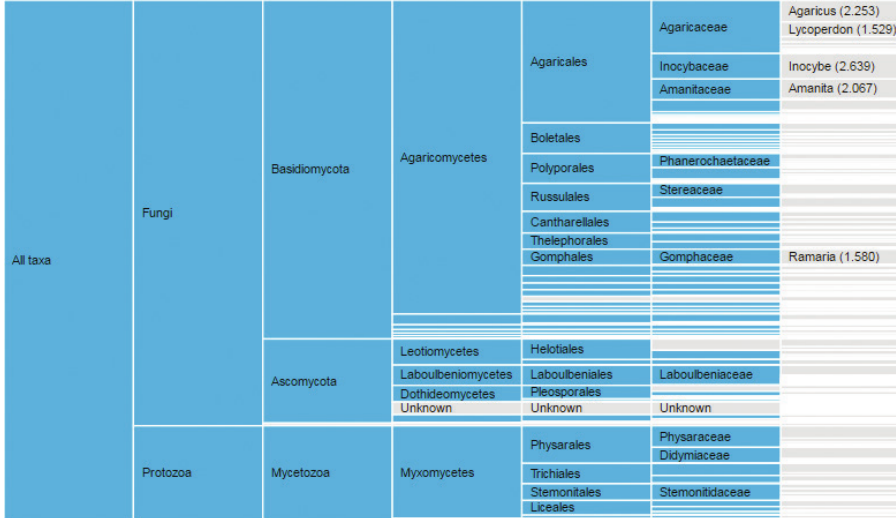
Figure 2. Visual representations of taxon record abundance in the dataset.